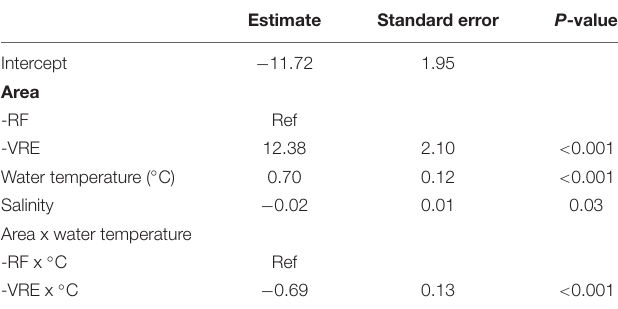
TABLE 3 | Generalized linear mixed effect model results of the association of the TABLE 2 | Generalized linear mixed effect model results of the association of the total count of mauve-purple colonies in the CHROMagar culture and total count of vibrio colonies in the CHROMagar culture and predictive factors. predictive Estimate Standard error P -value Intercept − 0.24 0.21